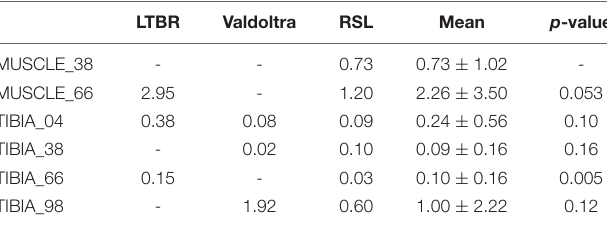
TABLE 3 | Measurement Uncertainty U Meas [% 2 ] of studies with two baseline measurements per body site.